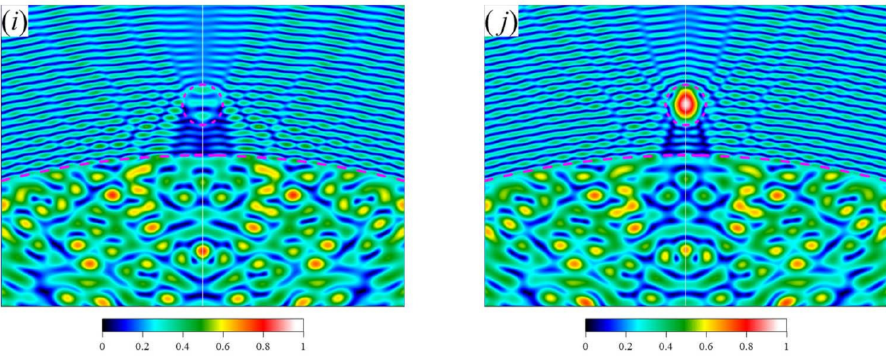
Figure 3. Normalized pressure distributions in the composite systems (Cases ( a – j )).